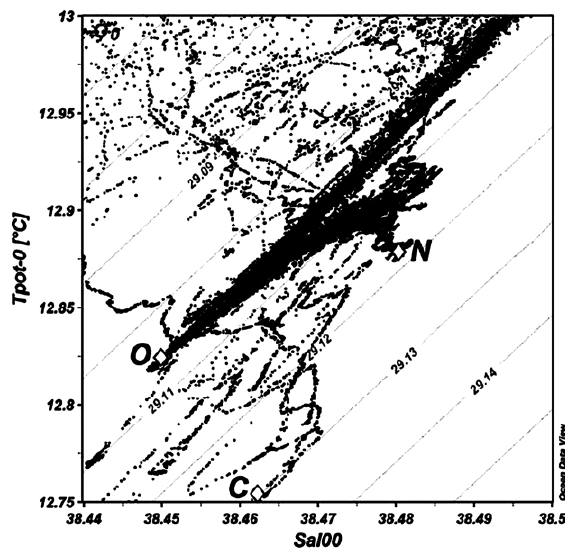
Fig. 4. – General θ -S diagram for Western Mediterranean Deep Wa- ter found during the Eflubio-2005 cruise (March 2005), showing the water types O, N and C involved in the formation of this water mass. Reproduced from Salat et al.